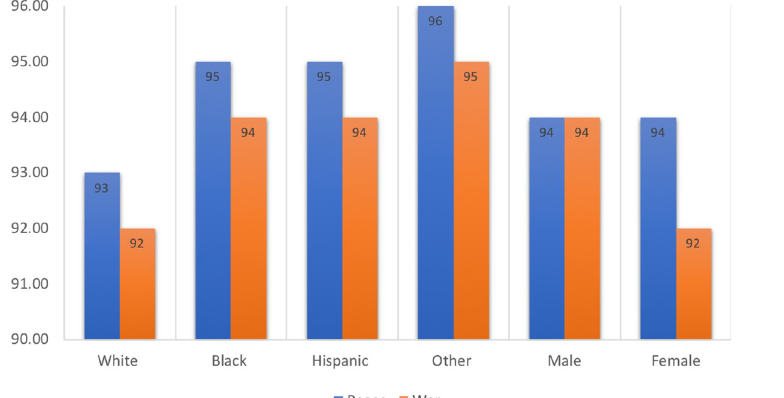
Fig 3. Retention rates (%) by racial-ethnic groups and sex during peace and